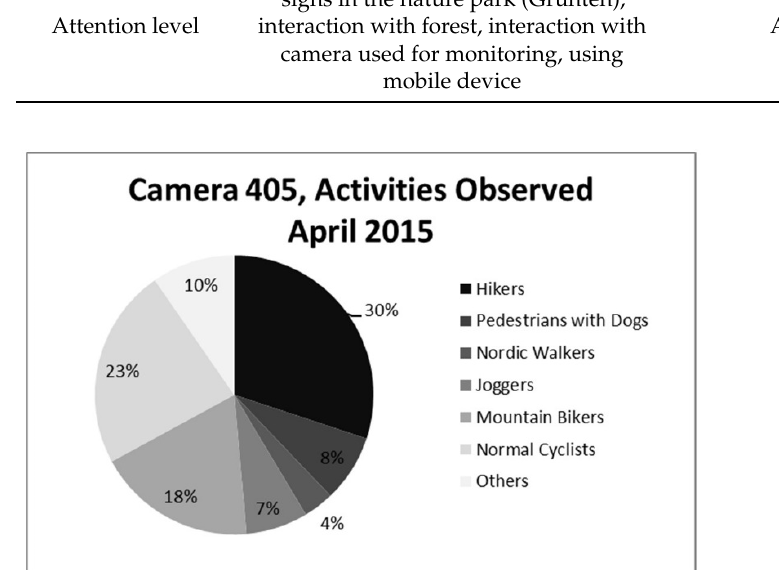
Figure 5. Percentages of observed activities at the monitoring site of camera 405, eastern entrance of the World Forest, Freising, Bavaria, Germany; during the monitored period, 2883 passersby were photographed.